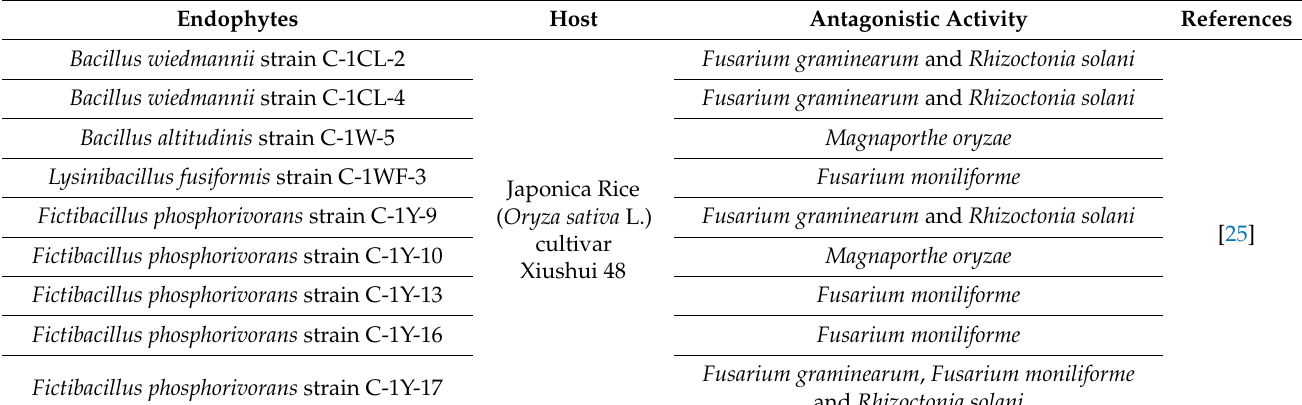
Table 1. Rice’s endophytic bacteria’s antagonism potential against various kinds of phytopathogens.